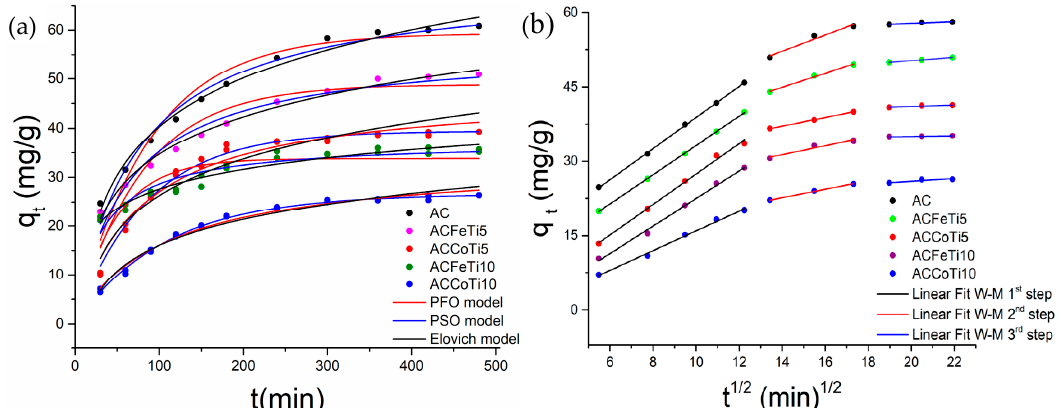
Figure 3. ( a ) Regression analysis and ( b ) intraparticle diffusion model of the adsorption kinetics process of CYF-4G on AC, ACFeTi5, ACFeTi10, ACCoTi5, and ACCoTi10 (conditions: 1.2 g/L of adsorbent dosage, concentration of (CYF-4G) = 100 mg/L, 120 rpm, T: 25 °C, and pH = 2).